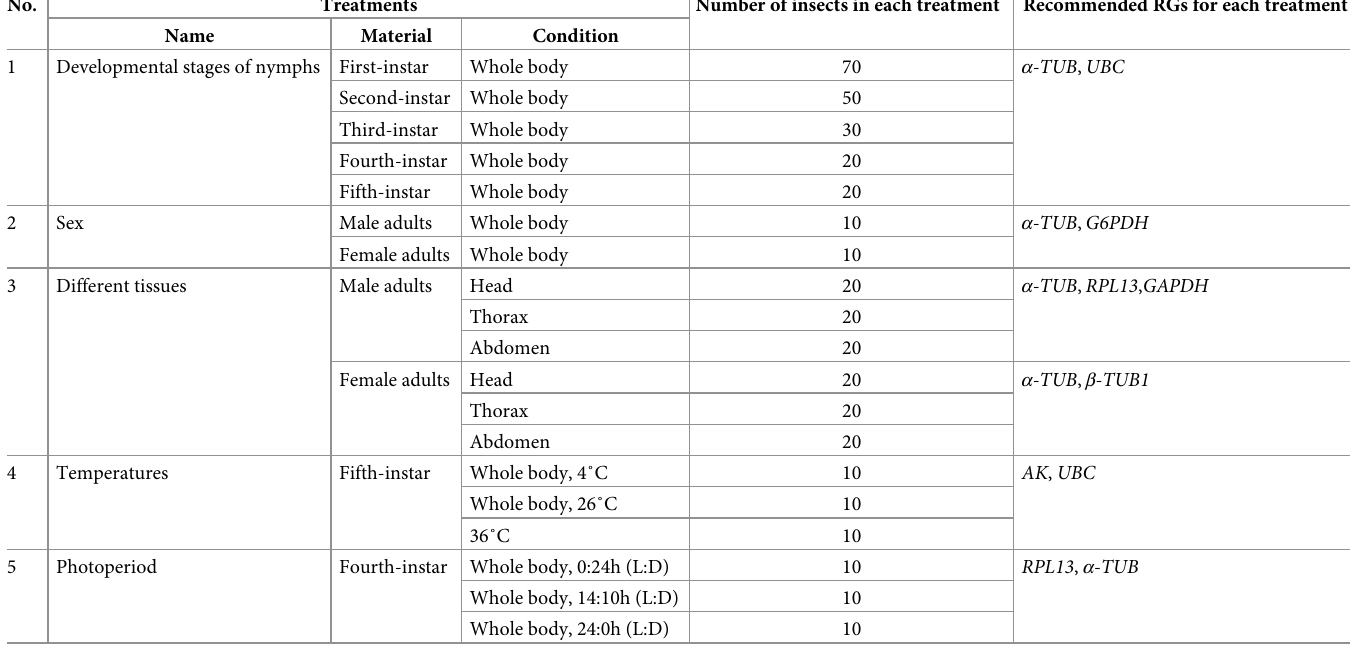
Table 1. Treatments and